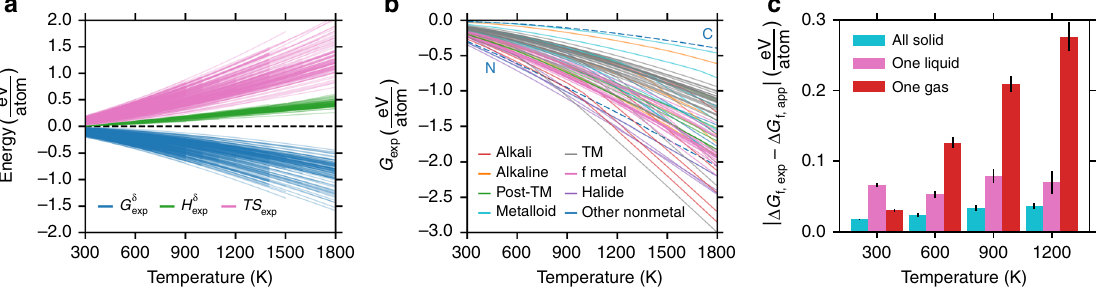
Fig. 1 Contributions to the Gibbs energies of compounds. a Experimentally obtained thermodynamic functions of 309 inorganic crystalline solid compounds obtained from FactSage. G δ is de fi ned in Eq. (1). H δ is the temperature dependence of the enthalpy normalized to be zero at 298 K (Supplementary Eq. 1), S is the absolute entropy, and T is temperature. The subscript, exp, indicates the quantity is obtained from experimental data. b Experimentally determined absolute Gibbs energies of 83 elements obtained from FactSage. G C ( “ C ” ) and G N ( “ N ” ) are dashed and labeled as they are mentioned in the text. The subscript, exp, indicates the quantity is obtained from experimental data. c Mean absolute error in assuming a cancellation of solid vibrational entropy between the compound and the elements comprising it. Δ G f ( T ) is de fi ned in Eq. (3). The subscript, app, stands for approximation and Δ G f,app ( T ) is de fi ned in Eq. (4). The error bars are standard errors of the sample mean. A violin plot corresponding with each bar is provided in Supplementary Fig.